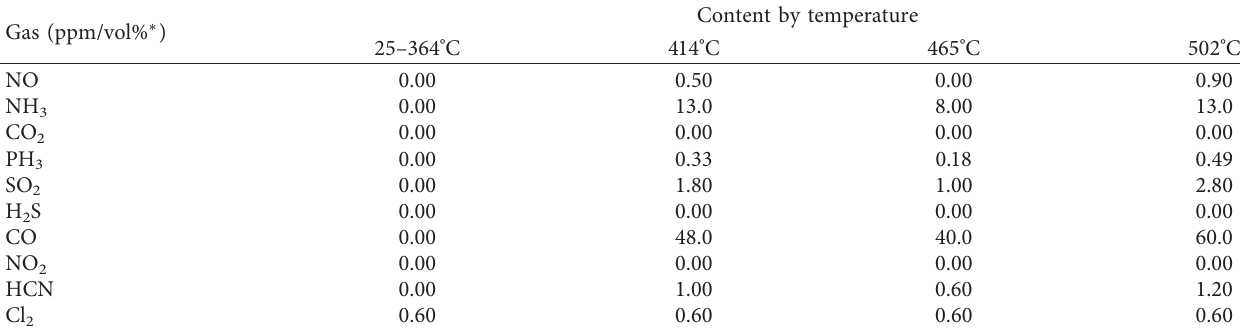
Table 3: Gas detected from the combustion of temer musa by gas sensors.